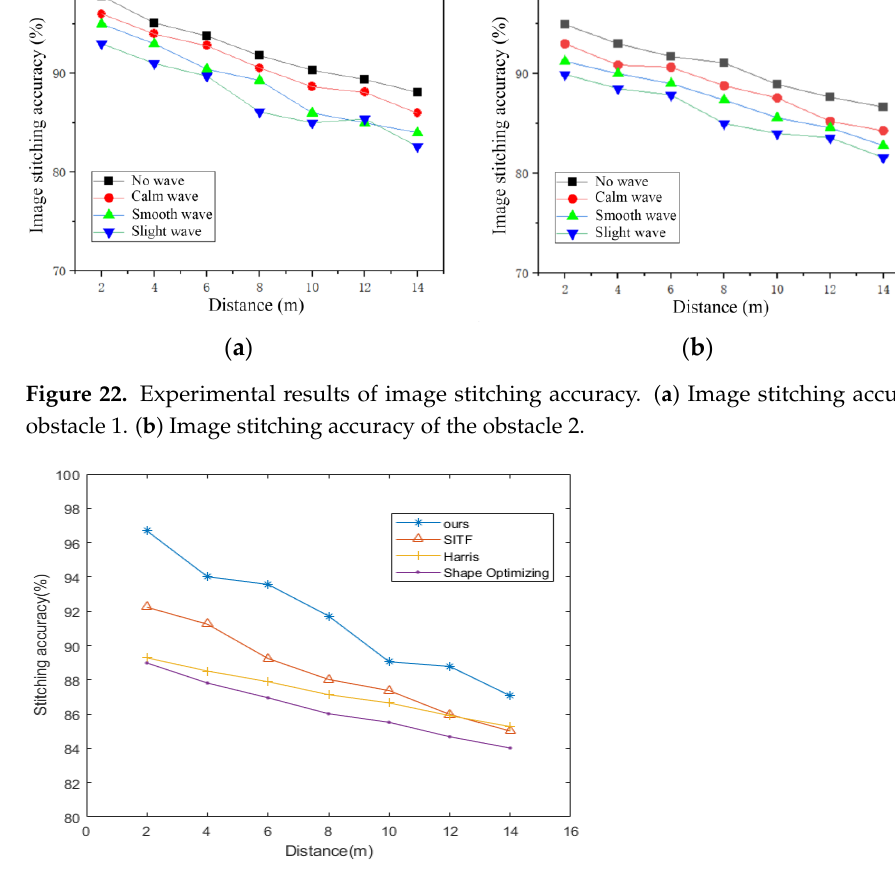
Figure 23. Comparison of stitching accuracy of different methods.